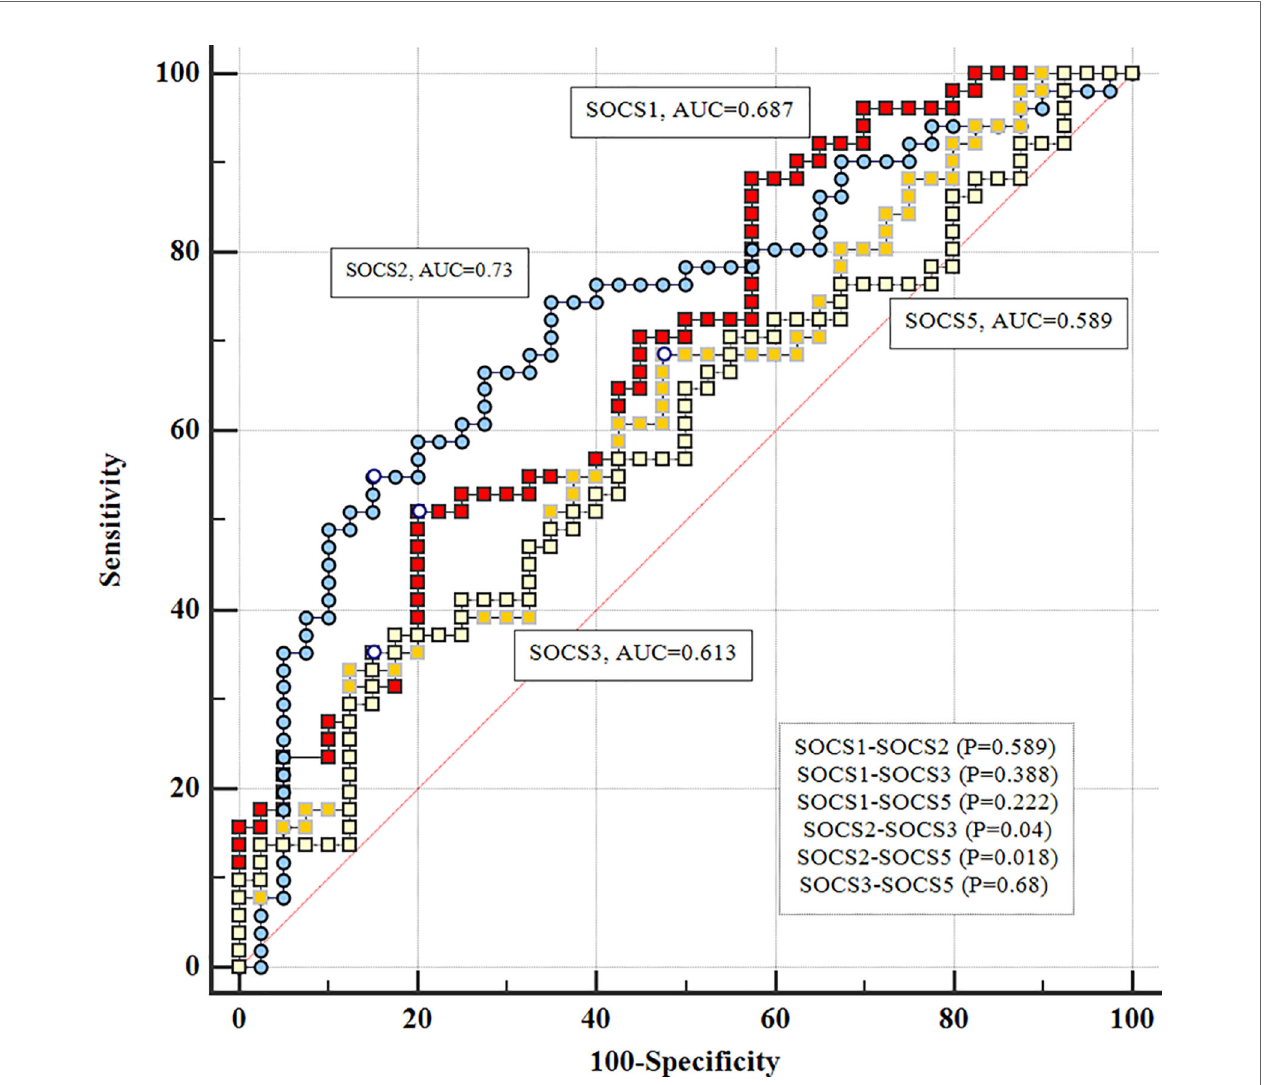
FIGURE 3 | Comparison of diagnostic power of SOCS genes in